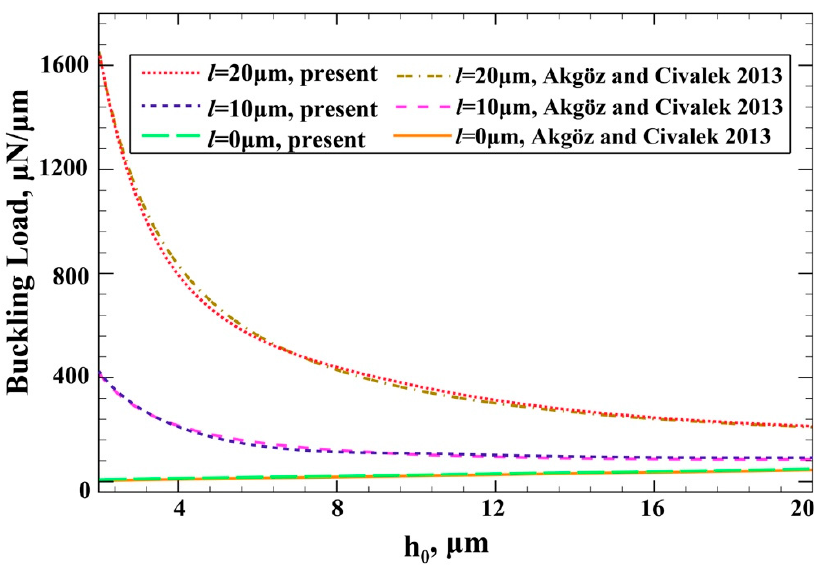
Figure 2. Comparison study of the buckling load of a uniform microplate with the details available in Ref. [63] subjected to uniform uniaxial compressive pressure for different values of length scale parameter versus thickness ( 𝑎 = 𝑏 = 50ℎ (cid:2868) ). Table 3. Comparison of the non-dimensional critical buckling loads of an elastic plate with variable thickness subjected to uniform uniaxial compressive pressure.